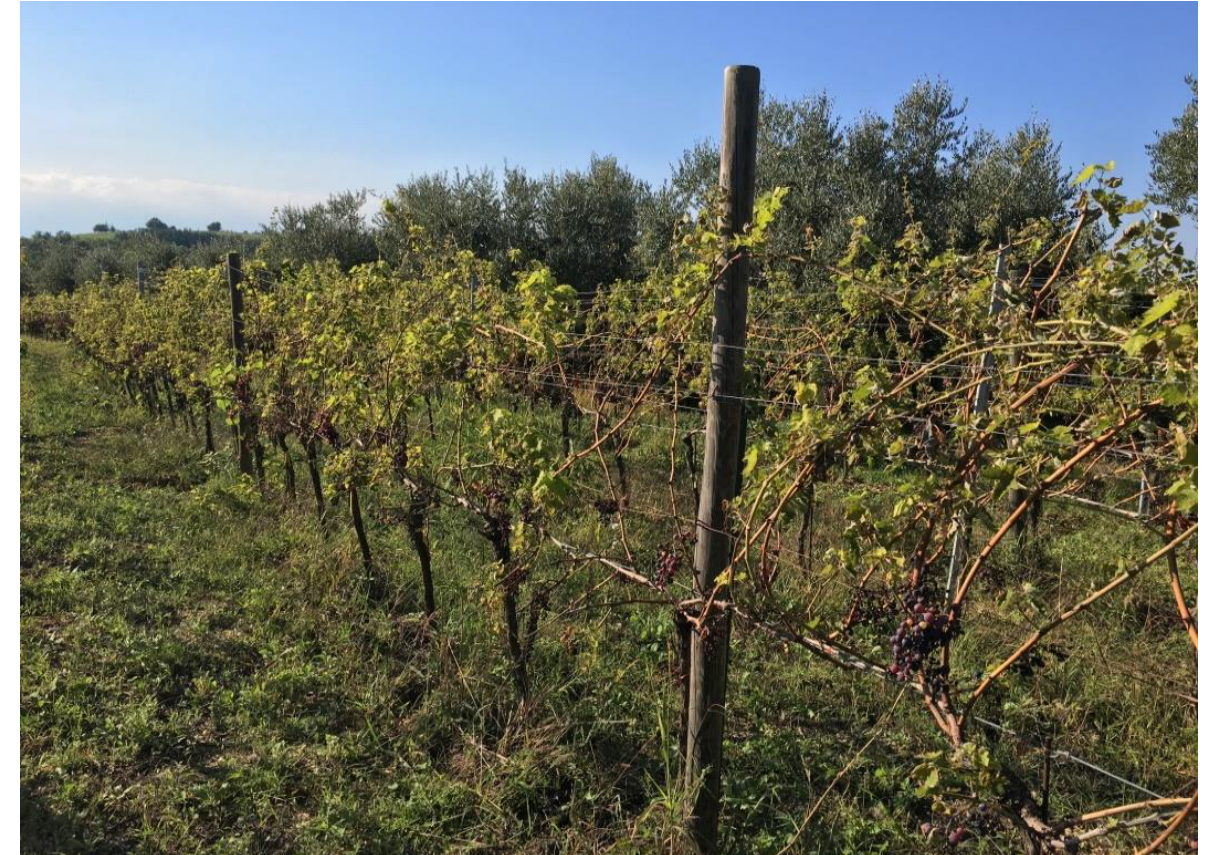
Figure 1. Untreated control plants at the end of the 2016 season. Bunches were completely damaged by downy mildew infection.